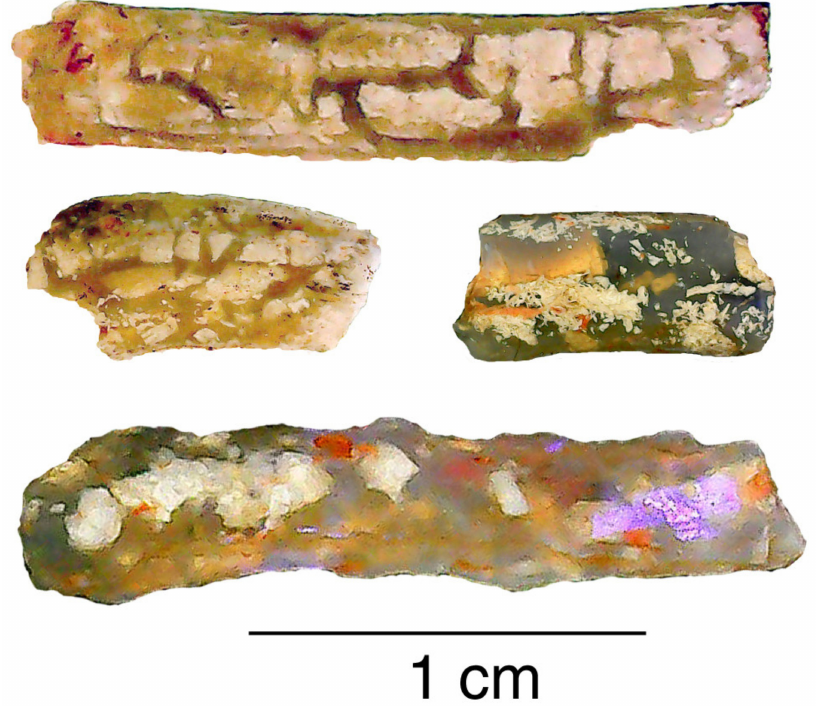
Figure 46. Opal-A casts of small twigs from Lightning Ridge, New South Wales, Australia. The interiors contain angular clasts of mudstone from the adjacent matrix. Specimens provided by Elisabeth Smith, Australian Opal Center at Lighting